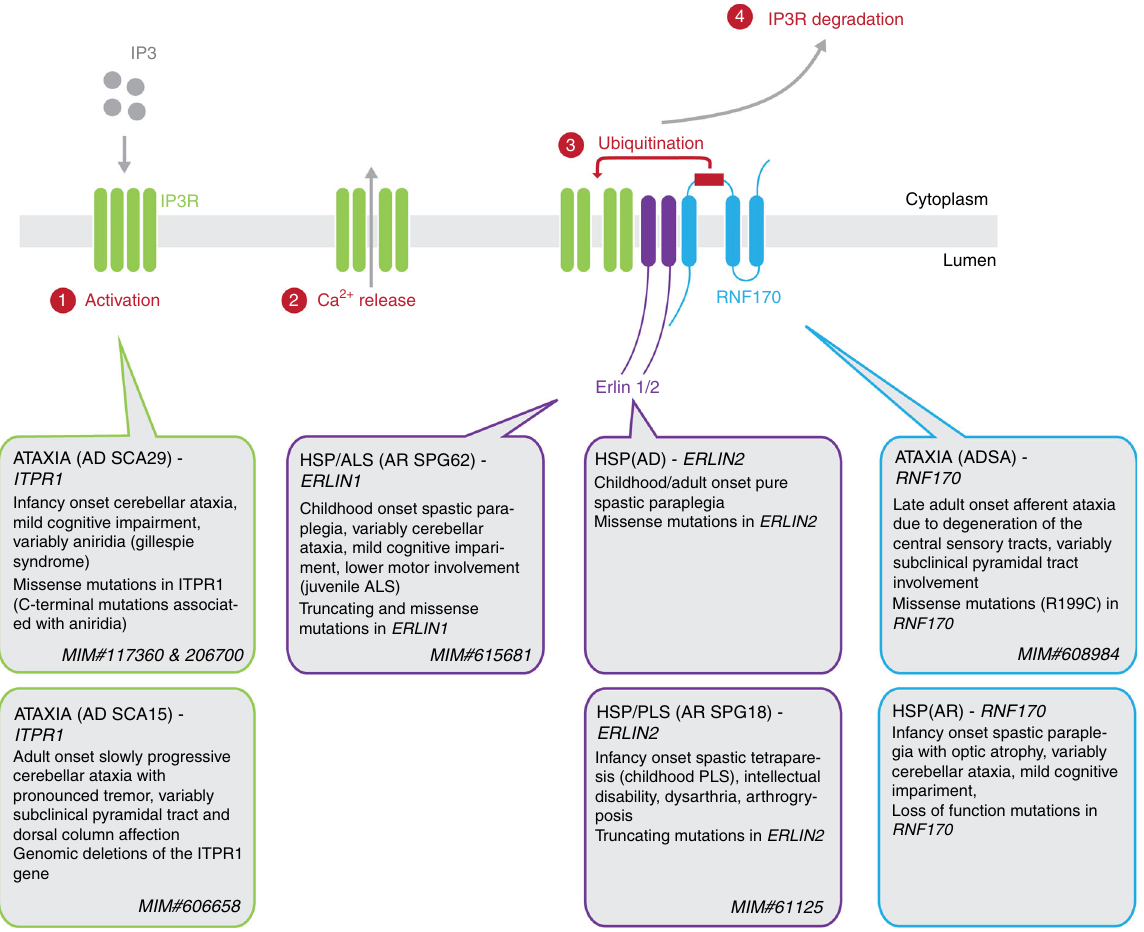
Fig. 6 RNF170-dependent degradation of activated IP3R and genetic disorders affecting this pathway. Upon activation of the IP3R with IP3, calcium is released from the ER into the cytoplasm. This triggers the association of IP3R with the ERLIN1/2 complex leading to the ubiquitination of IP3R by the E3 ubiquitin ligase RNF170, resulting in the proteasomal degradation of IP3R. Mutations in all genes encoding components of this pathway are known to cause hereditary neurologic disorders, especially spastic paraplegia and spinocerebellar